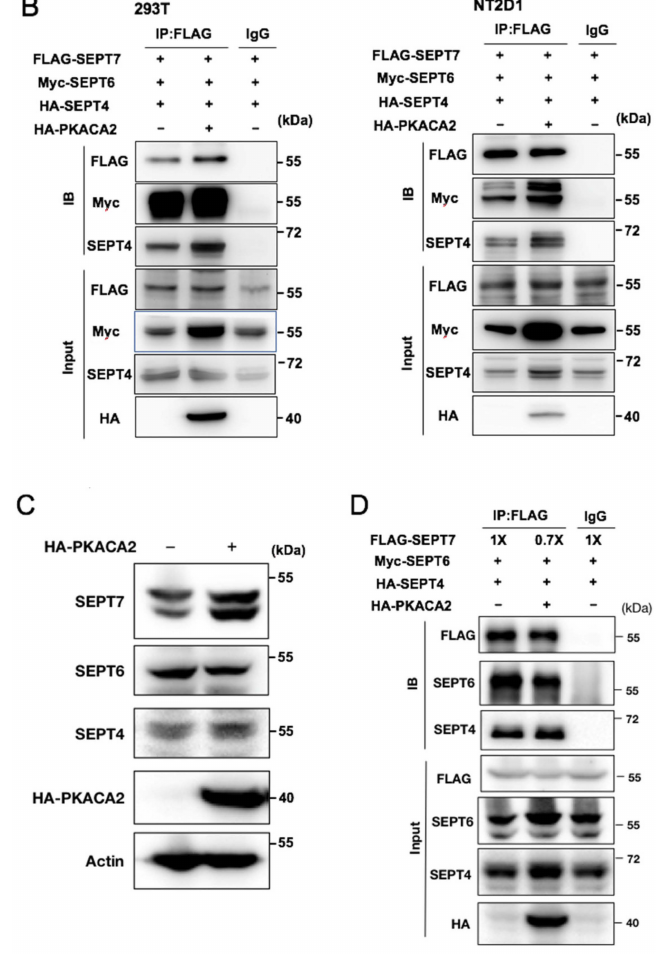
Figure 6. Overexpression of PKA disrupts SEPT7 filament formation. ( A , B ) 293T or NT2/D1 cell lines were co-transfected with FLAG-SEPT7 and GFP-SEPT7 ( A ), Myc-SEPT6 ( B , D ), or HA-SEPT4 ( B , D ), in the presence or absence of PKACA2 ( A – D ). Cell lysates were immunoprecipitated with an antibody against FLAG, and IgG served as a negative control. Following precipitation, samples were analyzed by immunoblotting assay with antibodies against GFP, Myc, HA, SEPT4, SEPT6, and SEPT7.